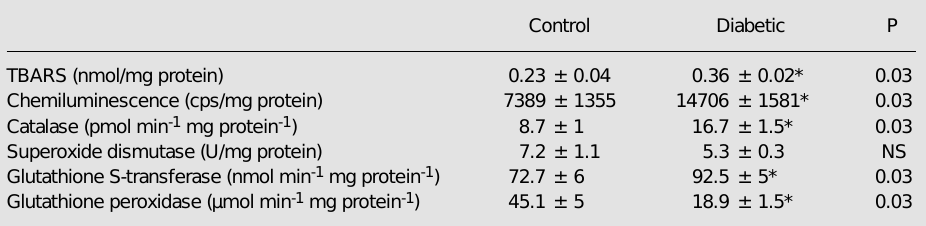
Table 1 - Determination of pro-oxidants (thiobarbituric acid reactive substances (TBARS) and chemilumines- cence) and antioxidants (catalase, superoxide dismutase, glutathione S-transferase and glutathione peroxi- dase activities) in latissimus dorsi muscle of control and diabetic rats. Data are reported as mean ± SEM. *P<0.05 compared to control (Student t -test). NS, Not significant. Control Diabetic P TBARS (nmol/mg